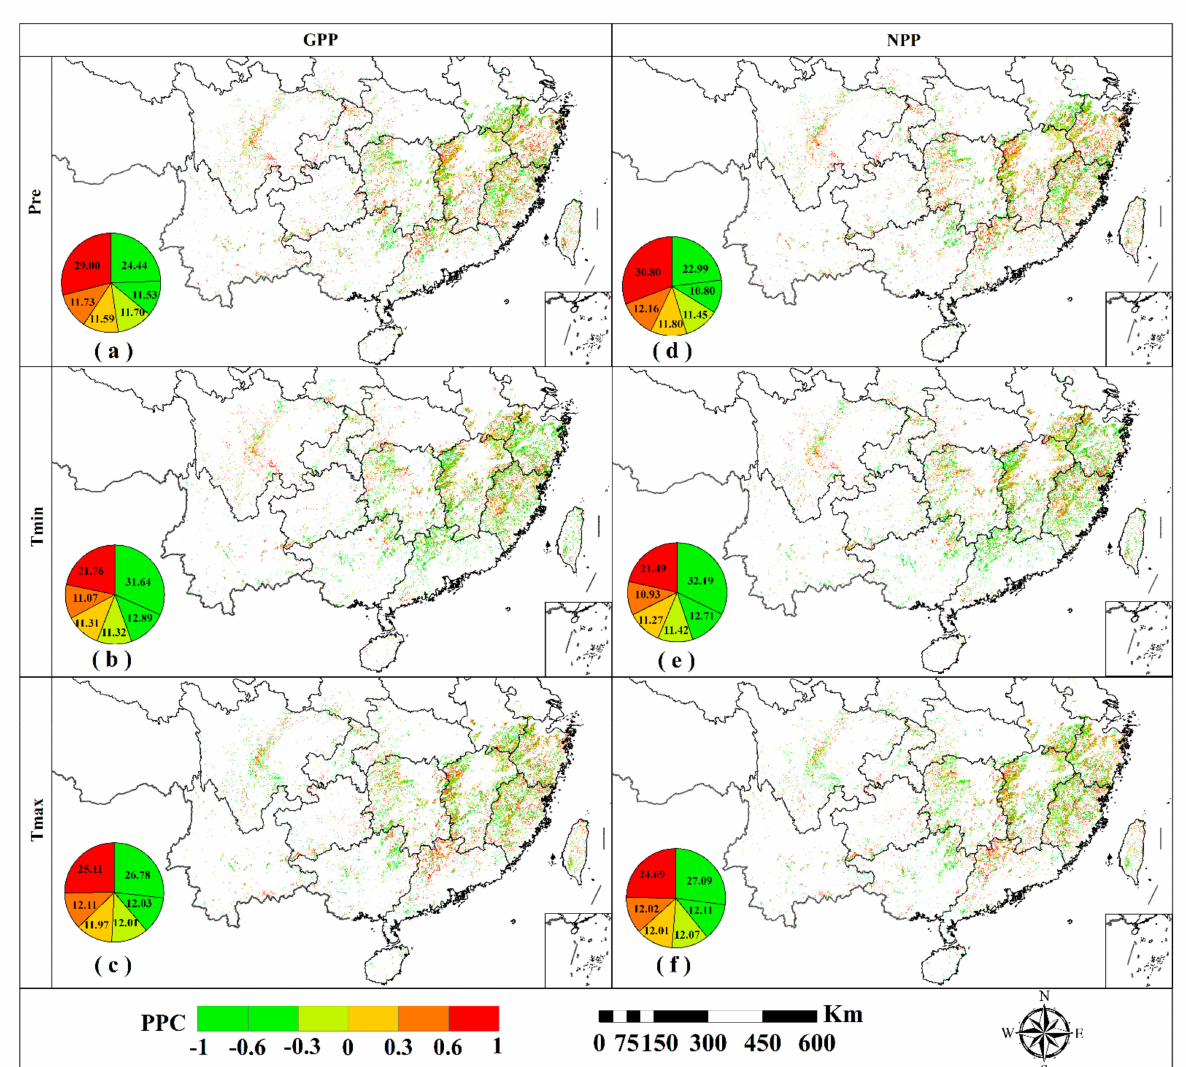
Figure 9. Spatial distribution of partial correlation coefficient (PPC) values of GPP with ( a ) precip- itation (Pre), ( b ) minimum temperature (T min ), and ( c ) maximum temperature (T max ); NPP with ( d ) precipitation (Pre), ( e ) minimum temperature (T min ), and ( f ) maximum temperature (T max ) of bamboo forests in China from 2001 to